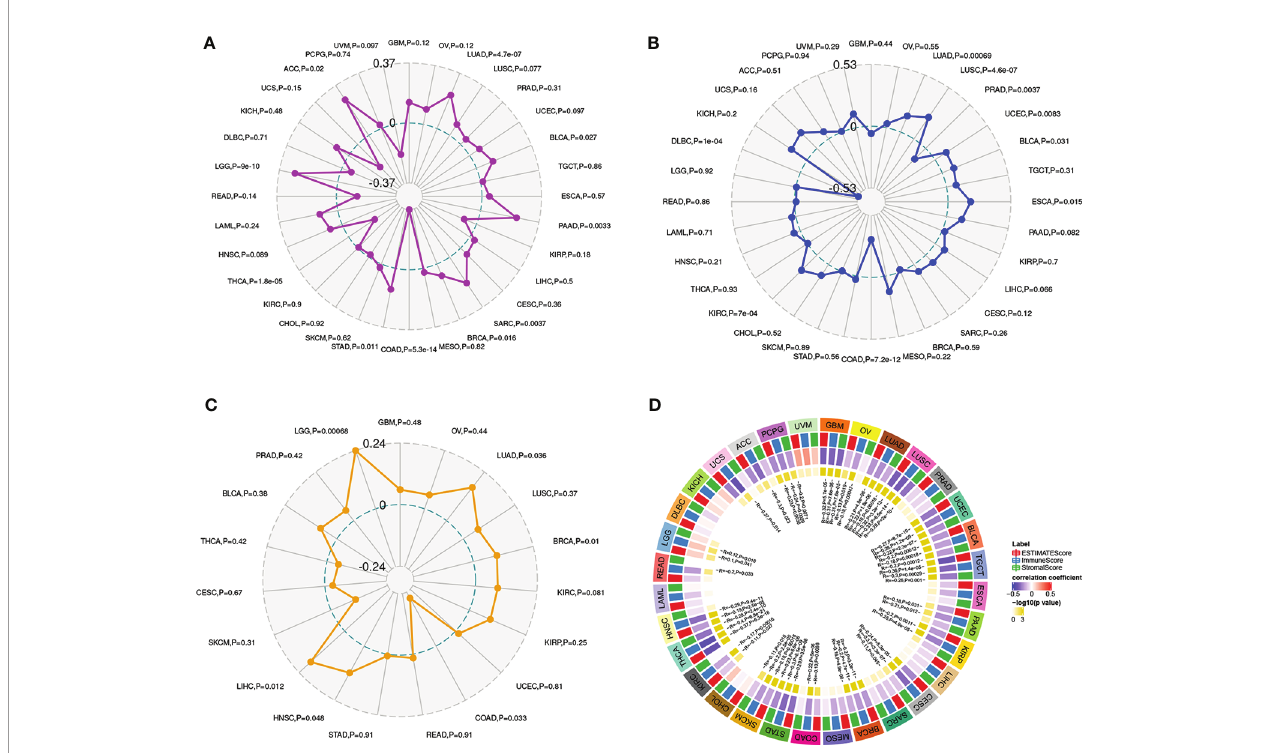
FIGURE 6 | The relationship between YTHDF1 expression and TMB (A) , MSI (B) , neoantigen (C) and ESTIMATE score (D) in human cancers. TMB, tumor mutational burden; MSI, microsatellite instability; MMR genes, mismatch repair genes; ESTIMATE, Estimation of Stromal and Immune cells in Malignant Tumor tissues using Expression data.